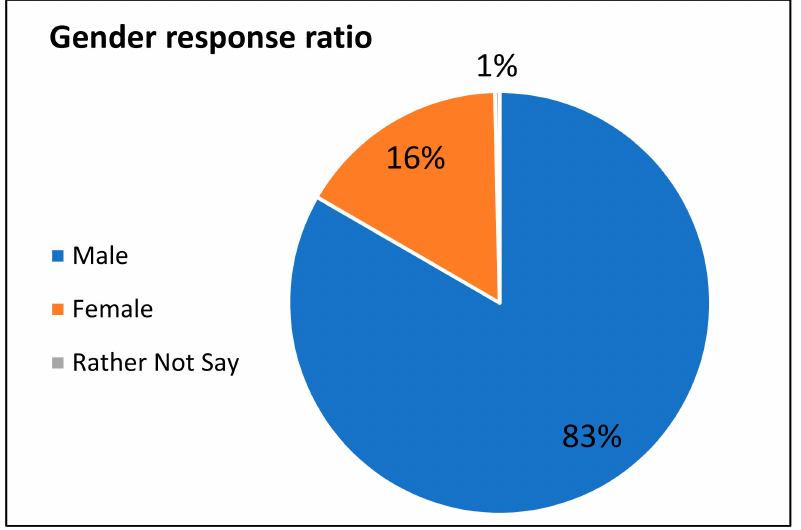
Figure 14. Survey gender response